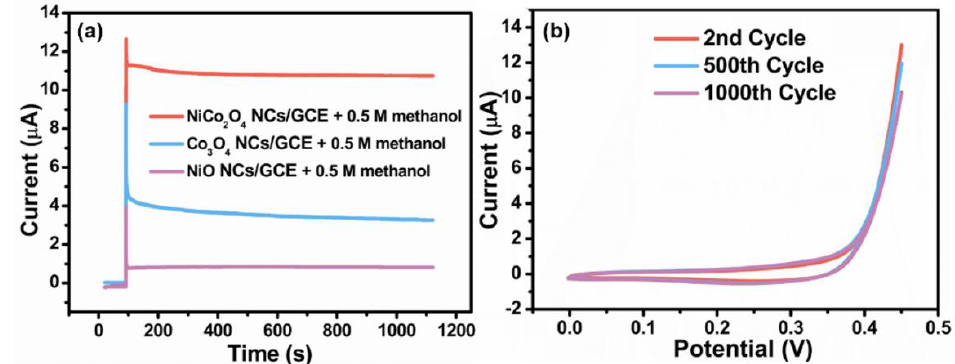
Figure 6. ( a ) The Chronoamperometry curves of NiCo 2 O 4 NCs/GCE, Co 3 O 4 NCs/GCE and NiO NCs/GCE in 0.5 M methanol. ( b ) The CV stability test of NiCo 2 O 4 NCs/GCE in 0.5 M methanol at a scanning rate of 50 mV s −1 .